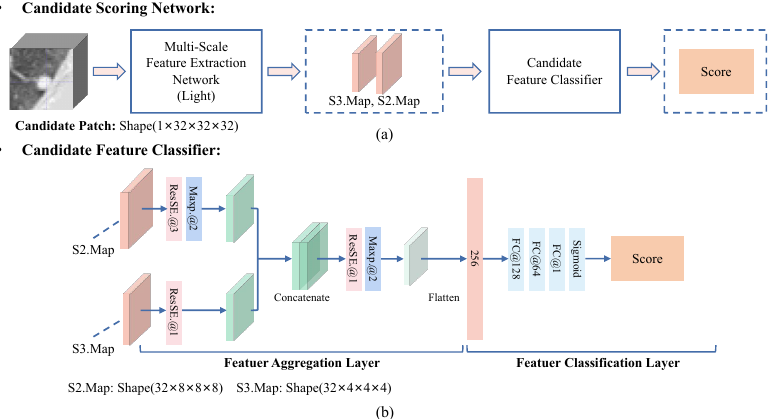
Figure 7. Flowchart of the proposed candidate scoring network (CS-Net). ( a ) The MSFD-Net consists of a lightweight multi-scale feature extractor and a candidate feature classifier. ( b ) The candidate feature classifier estimates the score of a candidate by integrating the multi-scale features of the